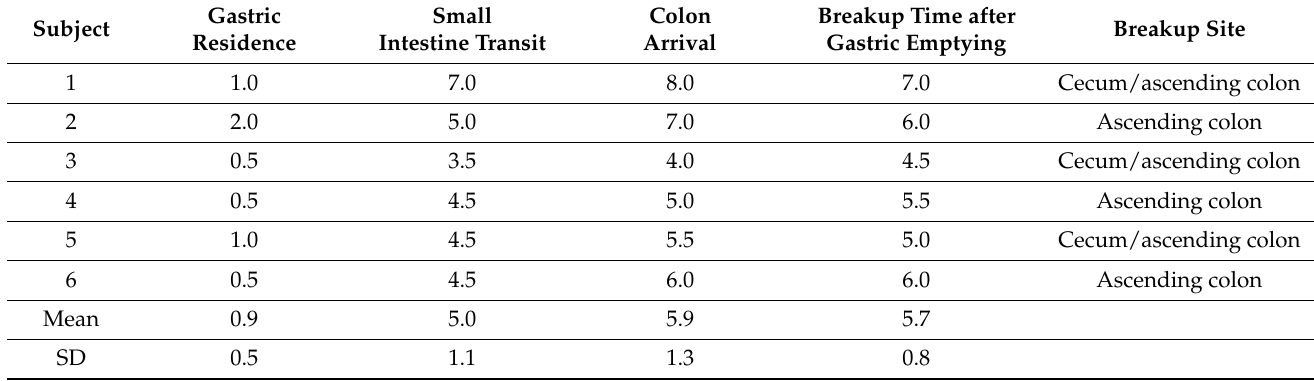
Table 6. Transit and disintegration times (h) of double-coated Chronotopic ® systems (Methocel ® E50 applied to 100% weight gain) in six volunteers. Data acquired by γ -scintigraphy. Adapted with permission from Ref. [61]. 2001,